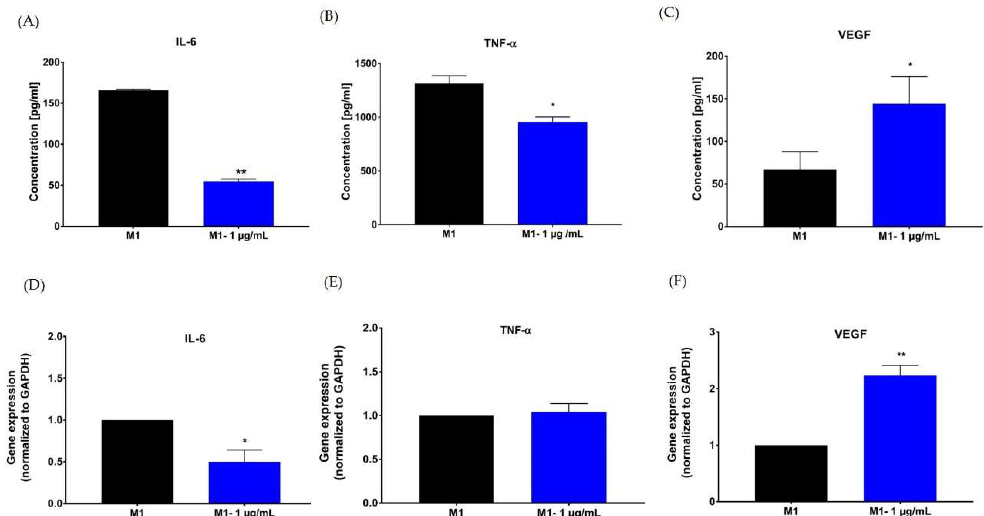
Figure 5. The influence of hypermongone C on cytokine expression in culture media was determined for ( A ) interleukin (IL)-6, ( B ) tumor necrosis factor (TNF)- α , and ( C ) vascular endothelial growth factor (VEGF) by enzyme-linked immunosorbent assay (ELISA) assay. Gene expression of ( D ) IL-6, ( E ) TNF-α, and ( F ) VEGF by M1 macrophages was determined after 24 h treatment hypermongone C using quantitative real-time PCR. Gene expression was normalized to the housekeeping gene GAPDH (internal control) and the control group (non-treated M1 macrophages (2 −ΔΔC )). * p ≤ 0.05 and ** p ≤ 0.01 as compared to the control group.